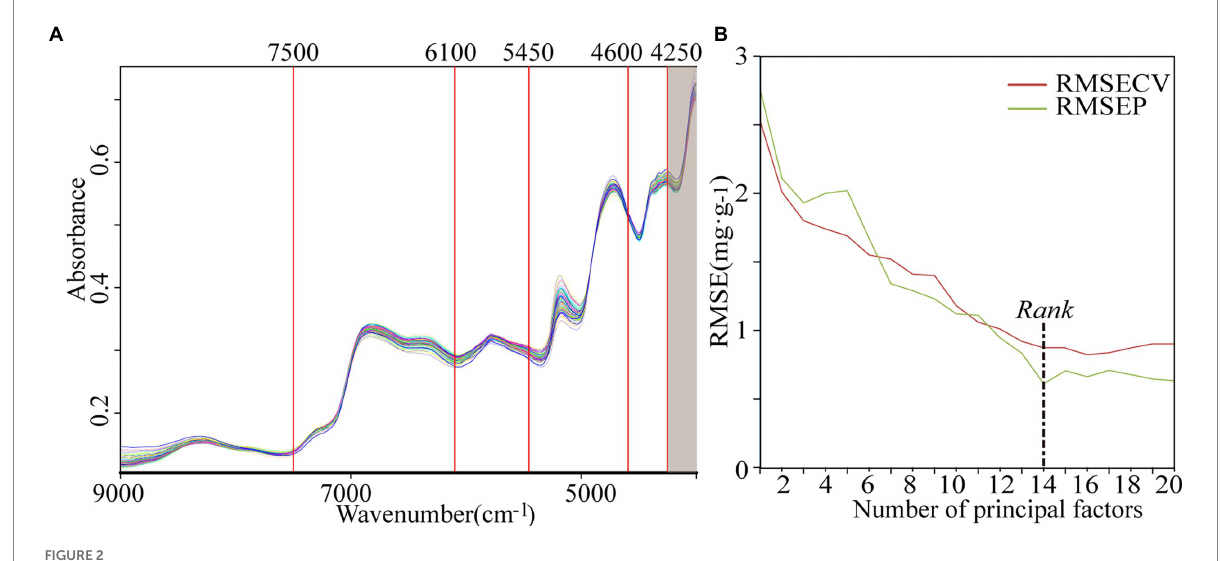
FIGURE 2 The characteristic interval division (A) and correlation curve between number of principal factors and RMSE in the PLS model (B) .